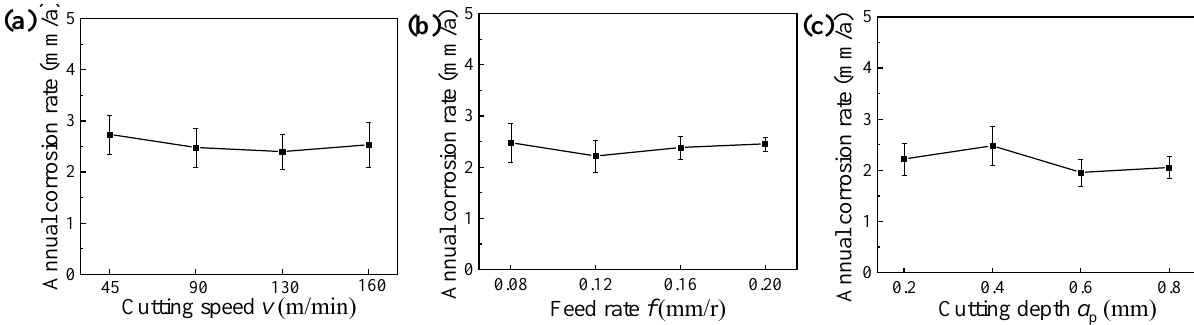
Figure 14. Annual corrosion rates of samples machined under different cutting parameters: ( a ) cutting speed, ( b ) feed rate, and ( c ) cutting depth.